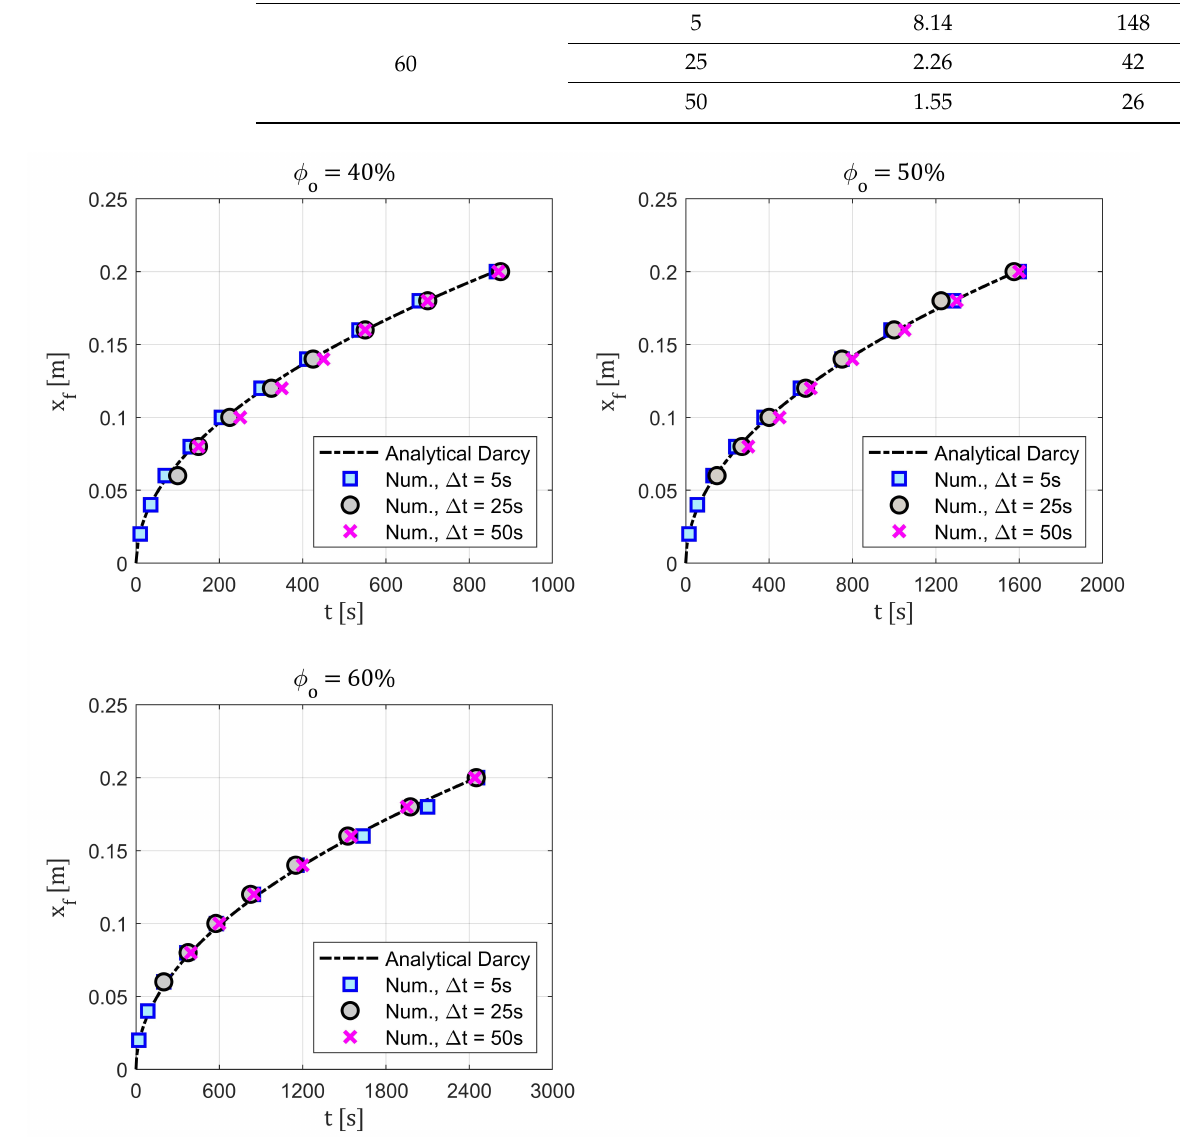
Figure 5. A comparative analysis for prediction of flow-front position as a function of